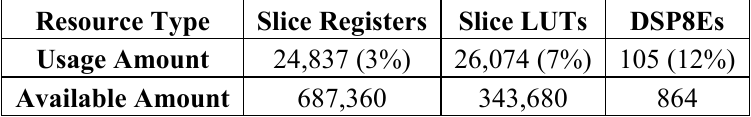
Table 2. Resource utilization of parallel strapdown